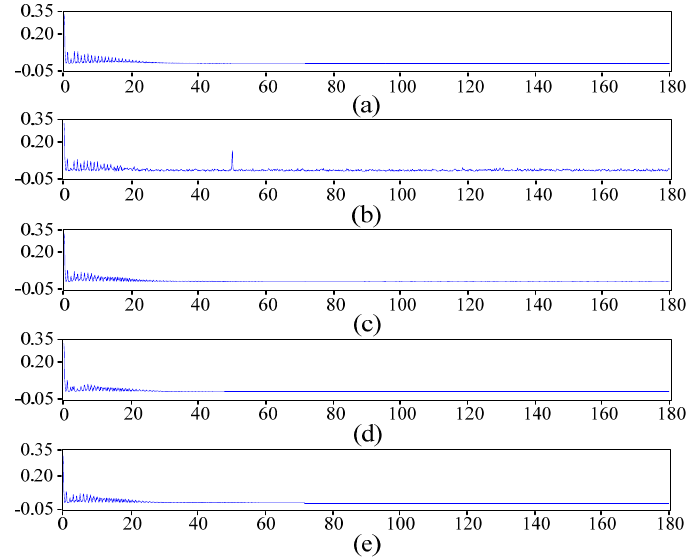
Figure 4. Spectrum of different signals. ( a ) Spectrum of the original signal; ( b ) Spectrum of the noisy signal; ( c ) Spectrum of the signal denoised by the soft threshold function; ( d ) Spectrum of the signal denoised by the hard threshold function; ( e ) Spectrum of the signal denoised by the improved threshold function.